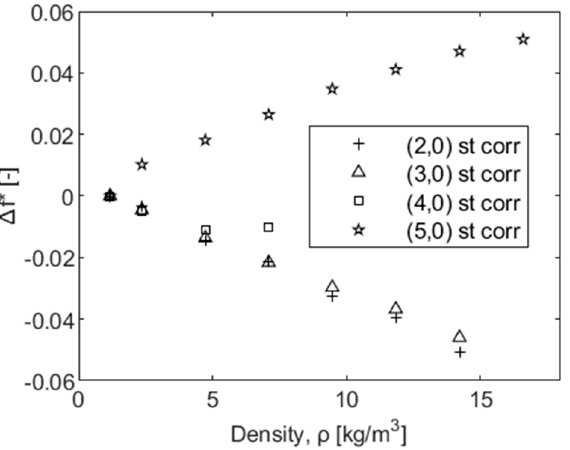
Figure 6. Corrected relative frequency changes of structure dominant modes in air for “slim cavity” over fluid density. Values corrected for added mass effect.